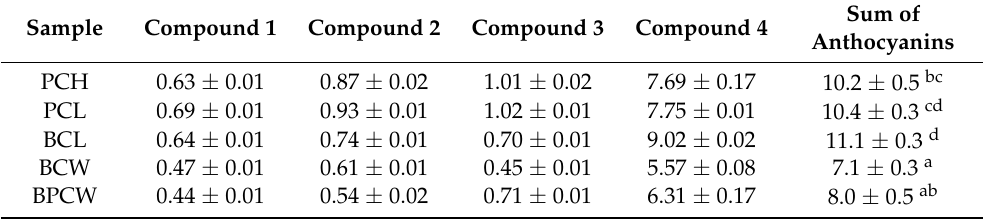
Table 3. Individual and the sum of anthocyanin content of different smoothies (mg/100 g; compound 1-cyanidin 3-xylosylglucosylgalactoside, compound 2-cyanidin 3-xylosylgalactoside, compound 3- sinapic acid derivative of cyanidin 3-xylosylglucosylgalactoside, compound 4-ferulic acid derivative of cyanidin 3-xylosylglucosylgalactoside).